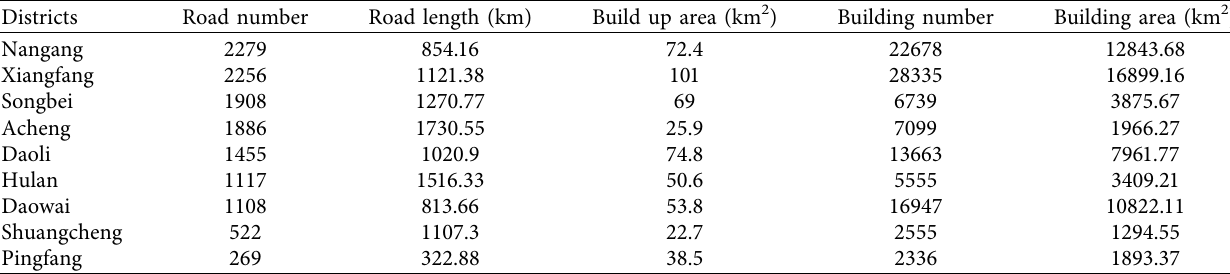
Table 3: Detailed data on the urban road network in Harbin.